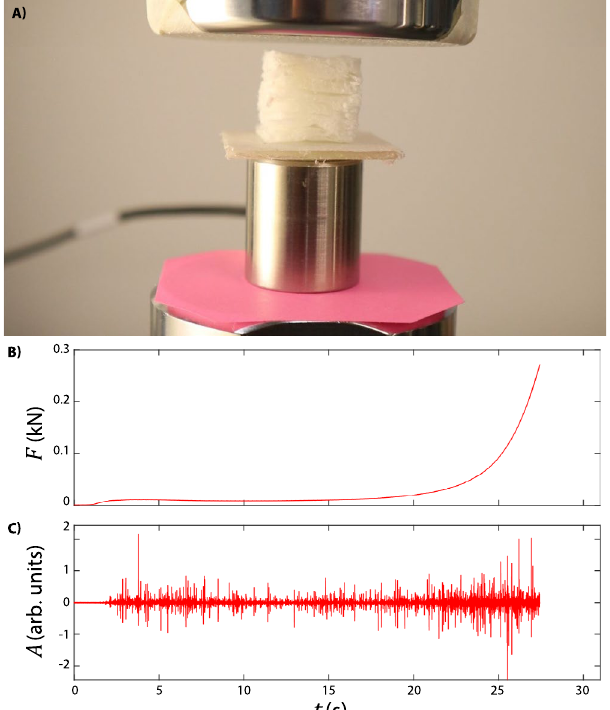
Figure 6. Compression protocol. ( A ) Sample between the two compression pistons of the Instron E1000 compression device. The pink paper at the bottom and the tape at the top break the acoustic connection between the machine and the AE sensor (steel cylinder). The sample is firmly attached to the AE sensor with double- sided tape to avoid sliding. The measured raw force ( B ) and AE amplitude ( C ) indicate a constant activity of structures